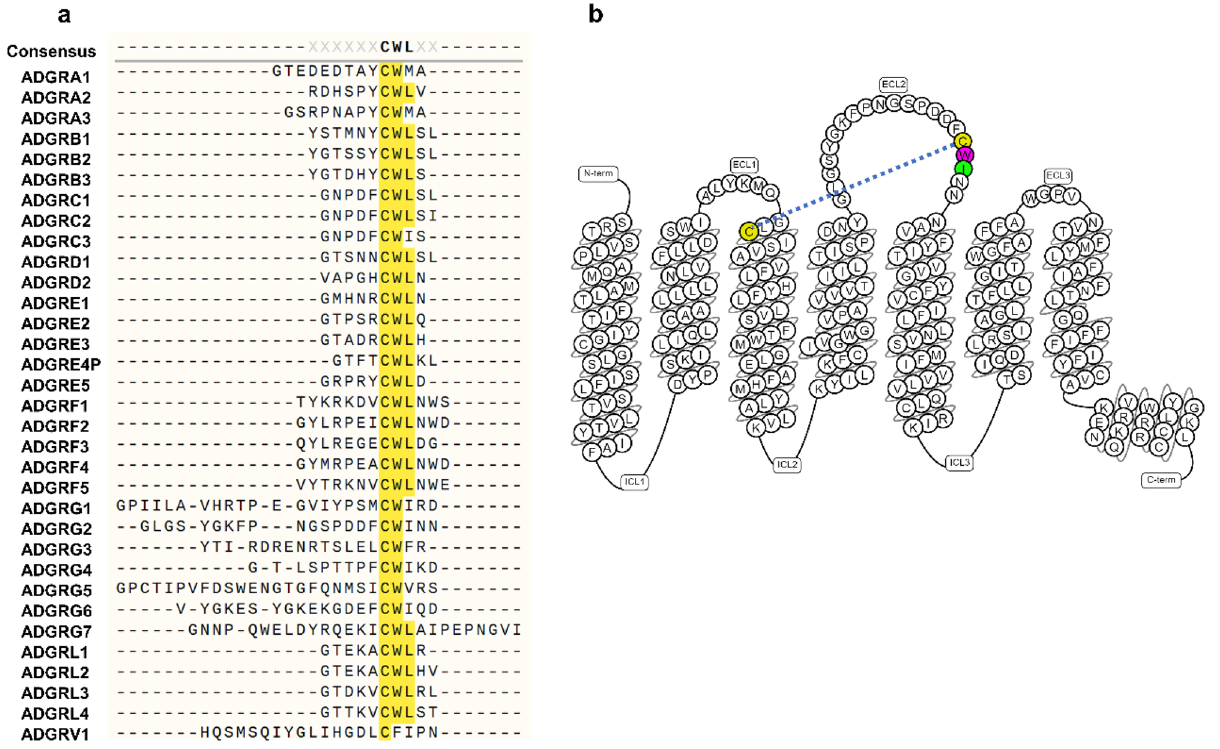
Figure 1. Conserved residues in the extracellular loop 2 (ECL2) of aGPCRs. ( a ) Multiple alignments of the ECL2 of all 33 members of the aGPCR family. Predicted amino acid sequences of the ECL2 for each aGPCR were derived from GPCRdb. The alignment was conducted in SnapGene software (from Insightful Science; available at www. snapg ene. com) using the Clustal Omega algorithm 46 . ( b ) Snakeplot of human ADGRG2, exported from www. GPCRdb. org, showing the colored CWI motif in the ECL2. The sequences of the N-terminal fragment and C-terminus are not shown. The dashed line shows the disulfide bond between the cysteines of TM3 and